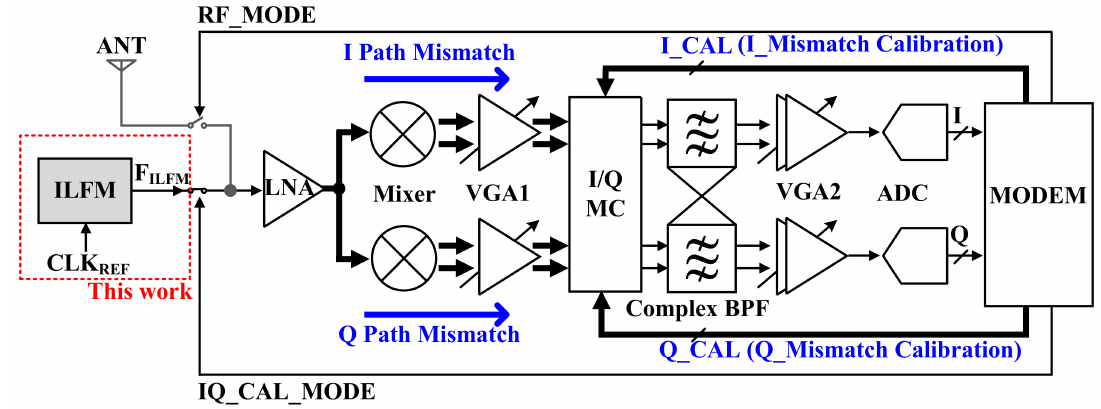
Figure 2. The block diagram of Low IF receiver with an Injection-Locked Frequency Multiplier